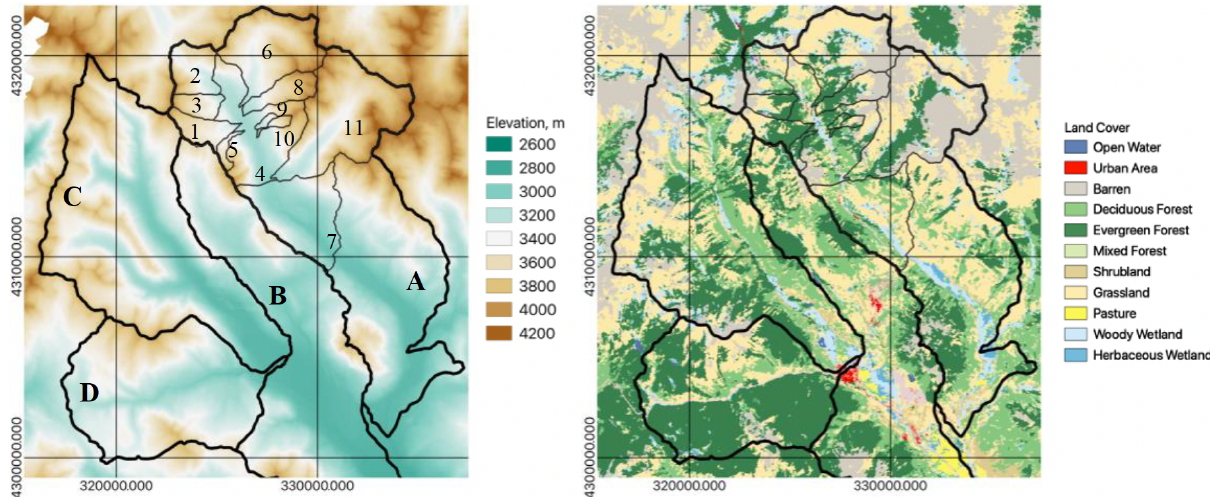
Figure 1. Study domain with (a) elevation and (b) land-cover map (USGS NLCD 2011 map; Homer et al., 2012). The black lines are the boundaries of the four watersheds: (A) East River, (B) Washington Gulch, (C) Slate River, and (D) Coal Creek. The thin black boundaries are subcatchments of the East River watershed from Carroll et al. (2018): (1) Rock, (2) East Above Quigley (EAQ), (3) Quigley, (4) East Below Copper (EBC), (5) Gothic, (6) Rustlers, (7) Pumphouse, (8) Bradley, (9) Marmot, (10) Avery, and (11)